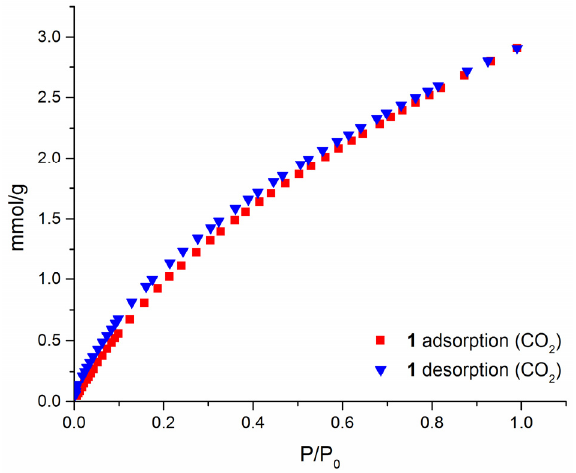
Figure 11. The CO 2 adsorption/desorption isotherm of 1 , measured at 0 °C.